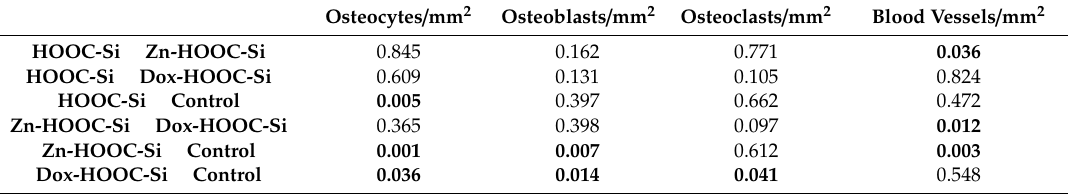
Table 6. Statistical results ( p values) after pairwise comparisons. Bold numbers mean significance at p <